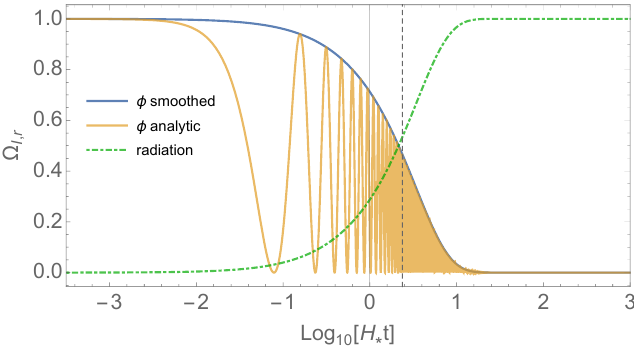
Figure 3 . The inflaton energy density Ω I ≡ ρ I / (3 M 2 smoothed and analytic approximations with an inflaton mass m depicts the energy density of radiation Ω